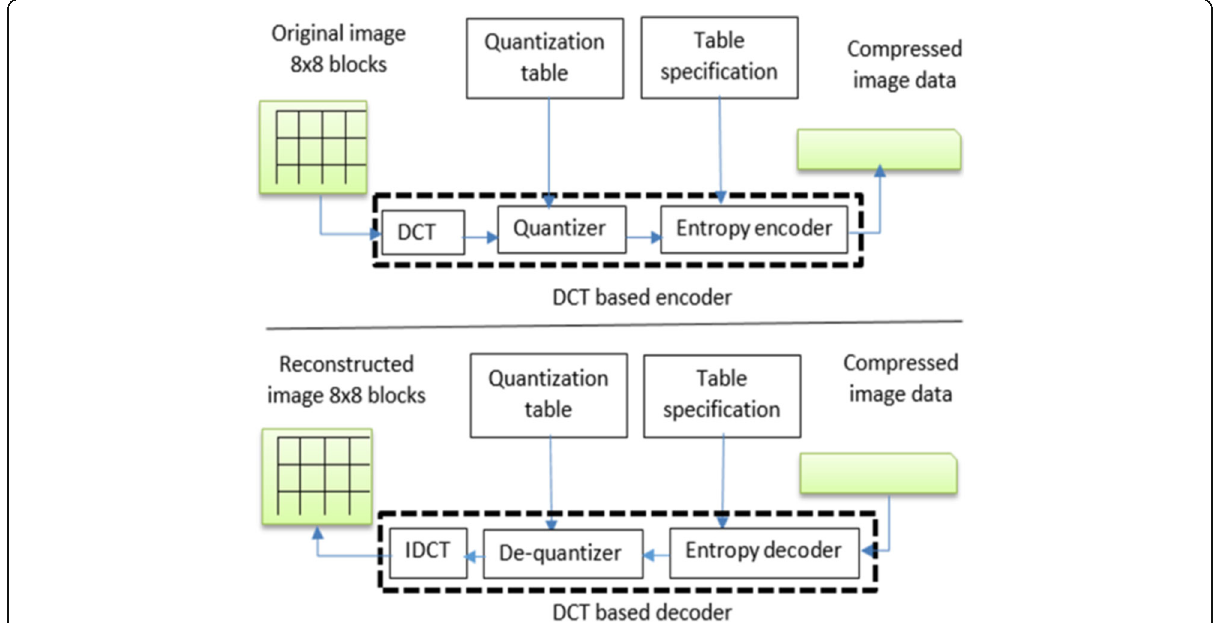
Fig. 2 Examples of JPEG quantization